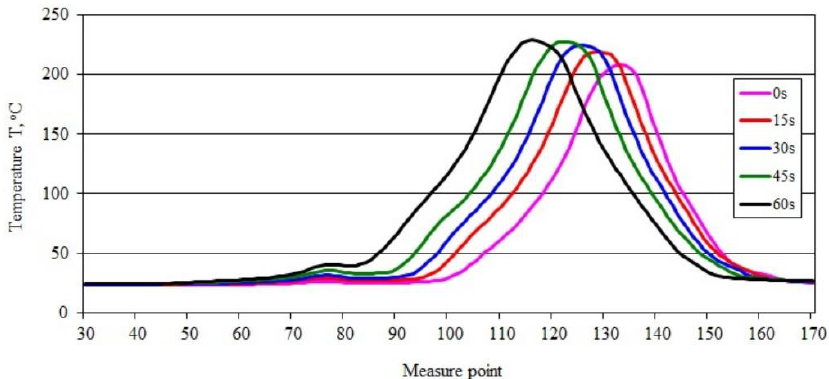
Figure 8. Temperature along the burning PBS50 sample recorded in area 2.